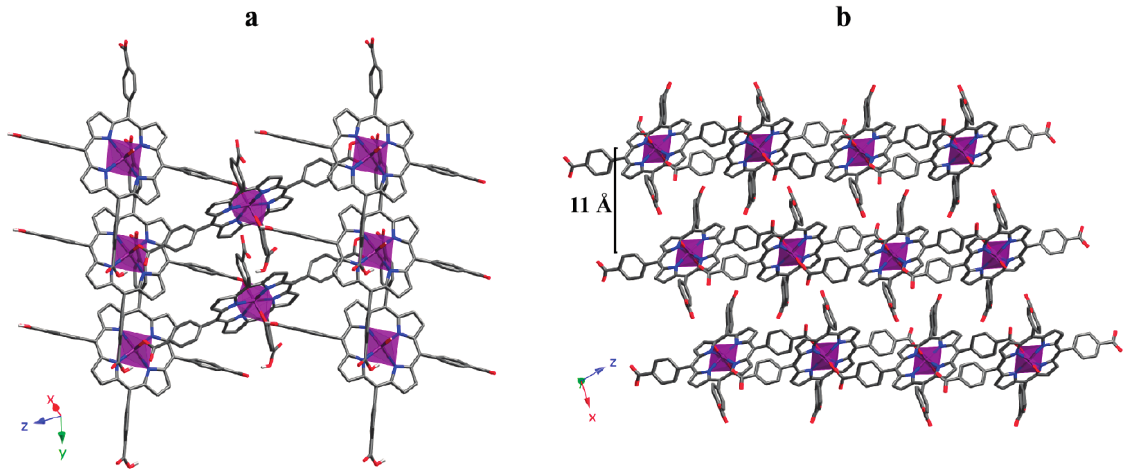
Figure 11. ( a ) View of a 2D layer and ( b ) projection of the 3D supramolecular array for compound 6 . (Fe: purple, C: grey, N: dark blue, O: red). H atoms have been omitted for